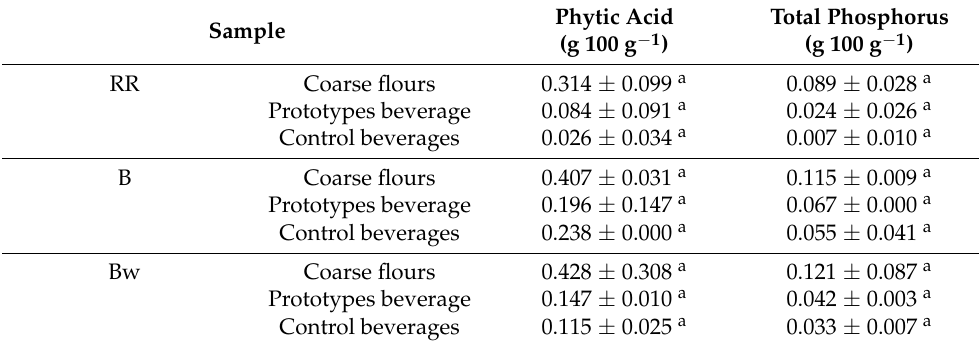
Table 5. Determination of phytic acid/total phosphorus of coarse flours, prototypes of fermented beverages and control beverage made with red rice (RR), barley (B) and buckwheat (Bw). Phytic Acid Total Phosphorus Sample (g 100 g − 1 ) (g 100 g − 1 ) RR Coarse flours 0.314 ± 0.099 a Prototypes